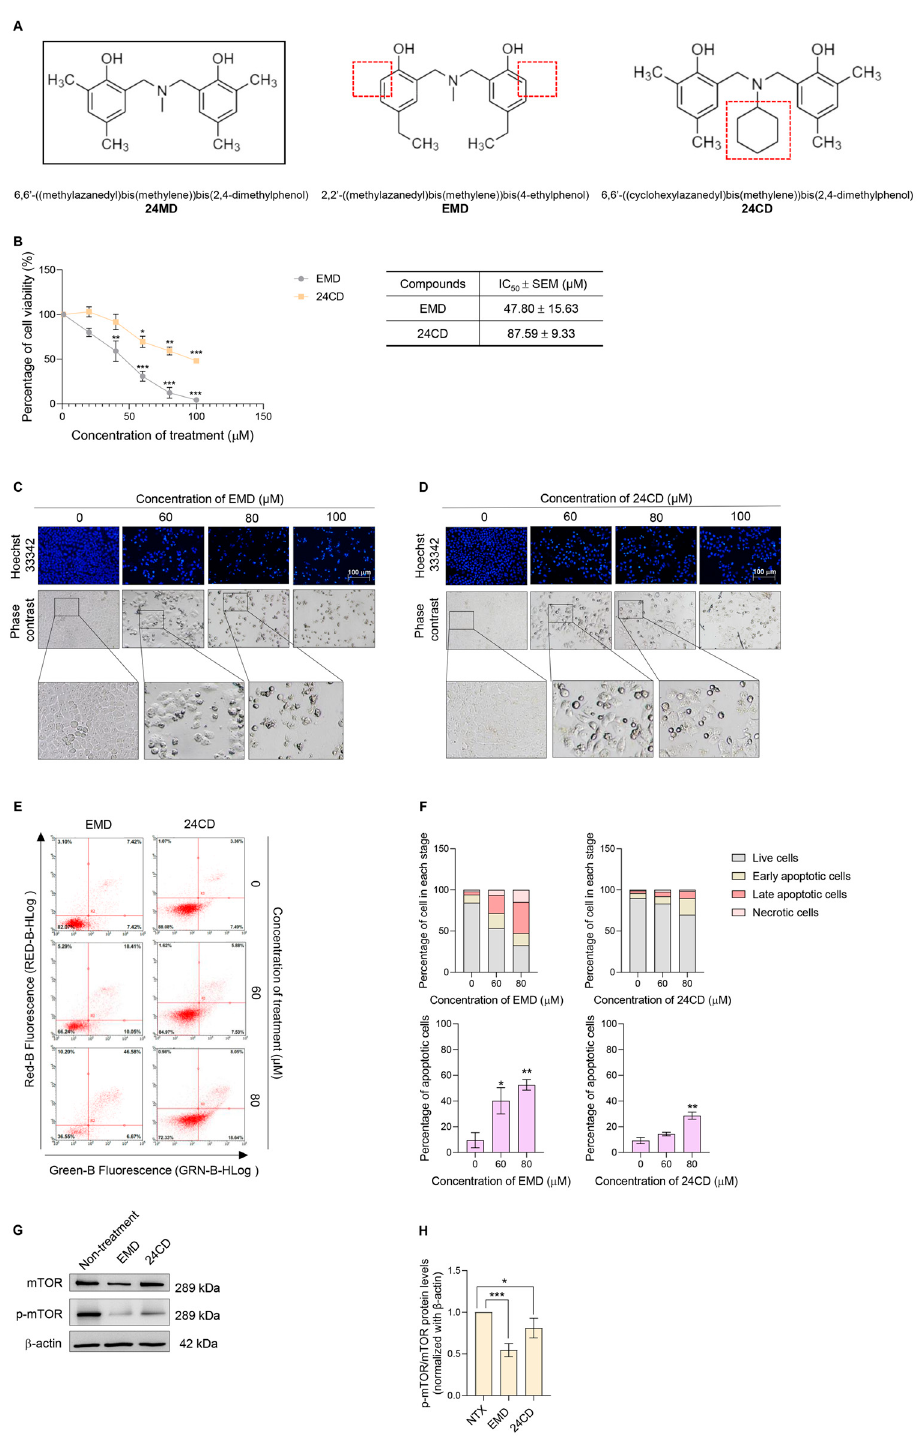
Figure 4. To demonstrate the structural related activity of 24MD, other benzoxazine dimer analogues, EMD and 24CD were applied for activity comparison. ( A ) Comparison of chemical structure between 24MD, EMD and 24CD. ( B ) The MTT assay was performed to evaluate the cytotoxicity of EMD and 24CD. A549 cells were treated with various concentrations of EMD and 24CD (0–100 μ M) for 24 h. The percentage of cell viability was calculated by comparison with non ‐ treatment control. The half maximal inhibitory concentration (IC 50 ) of EMD and 24CD at 24 h against A549 cells were estimated by using linear regression equation. ( C , D ) Nuclear staining with Hoechst 33342 was performed to access morphological changes of nucleus after EMD and 24CD treatment (0–100 μ M) for 24 h. The morphological changes of the A549 cells were visualized under phase contrast microscope.